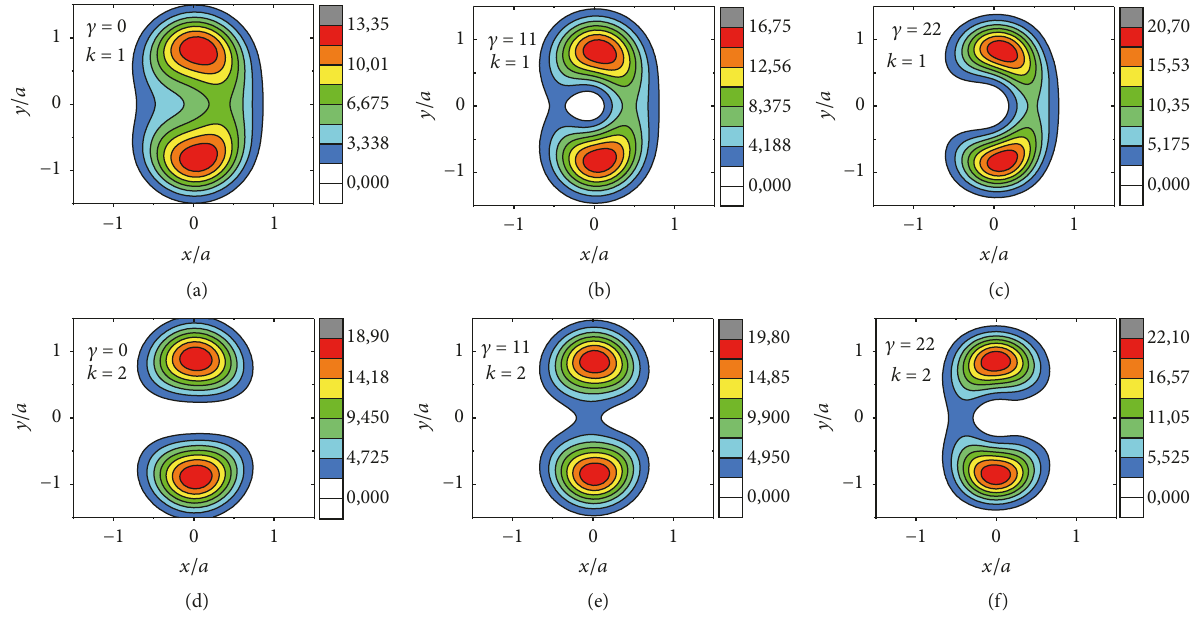
Figure 10: Charge distribution in elongated QR with the eccentricity parameter 𝑒 = 1 induced by off-axis donor ( 𝜌 𝑖 = 20 nm) in the ground and in the first excited states for the magnetic fields 𝛾 = 0 , 𝛾 = 11 , and 𝛾 = 22